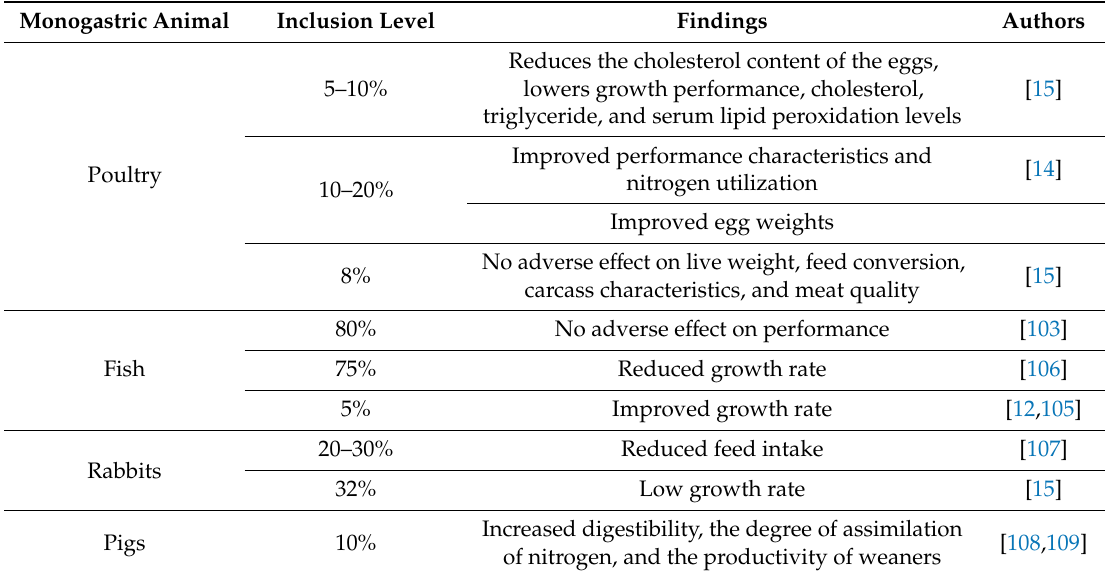
Table 4. E ff ect of amaranth leaf meal in diets of monogastric